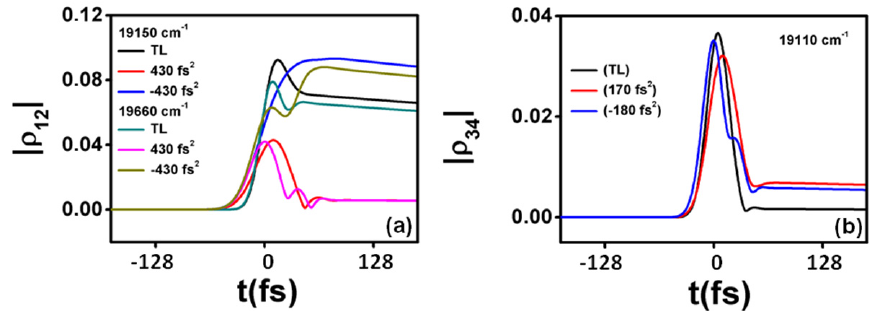
Figure 4. Time evolution of the vibrational coherences in the ground state ( a ); and in the upper states ( b ), for the indicated parameter values.